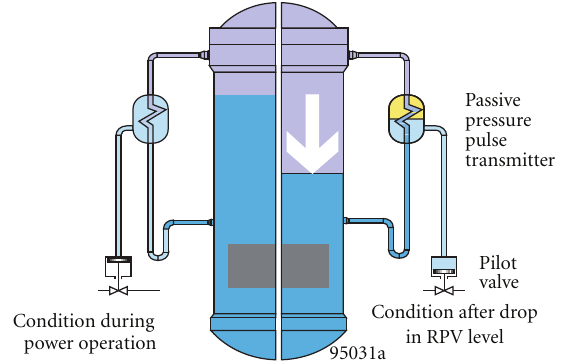
Figure 2: Operating Principle of the Passive Pressure Pulse Trans- mitter.